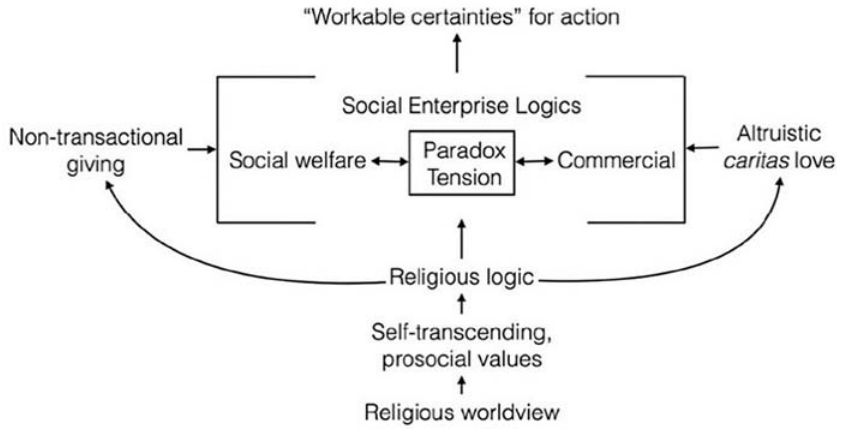
Figure 2. Contextual model.